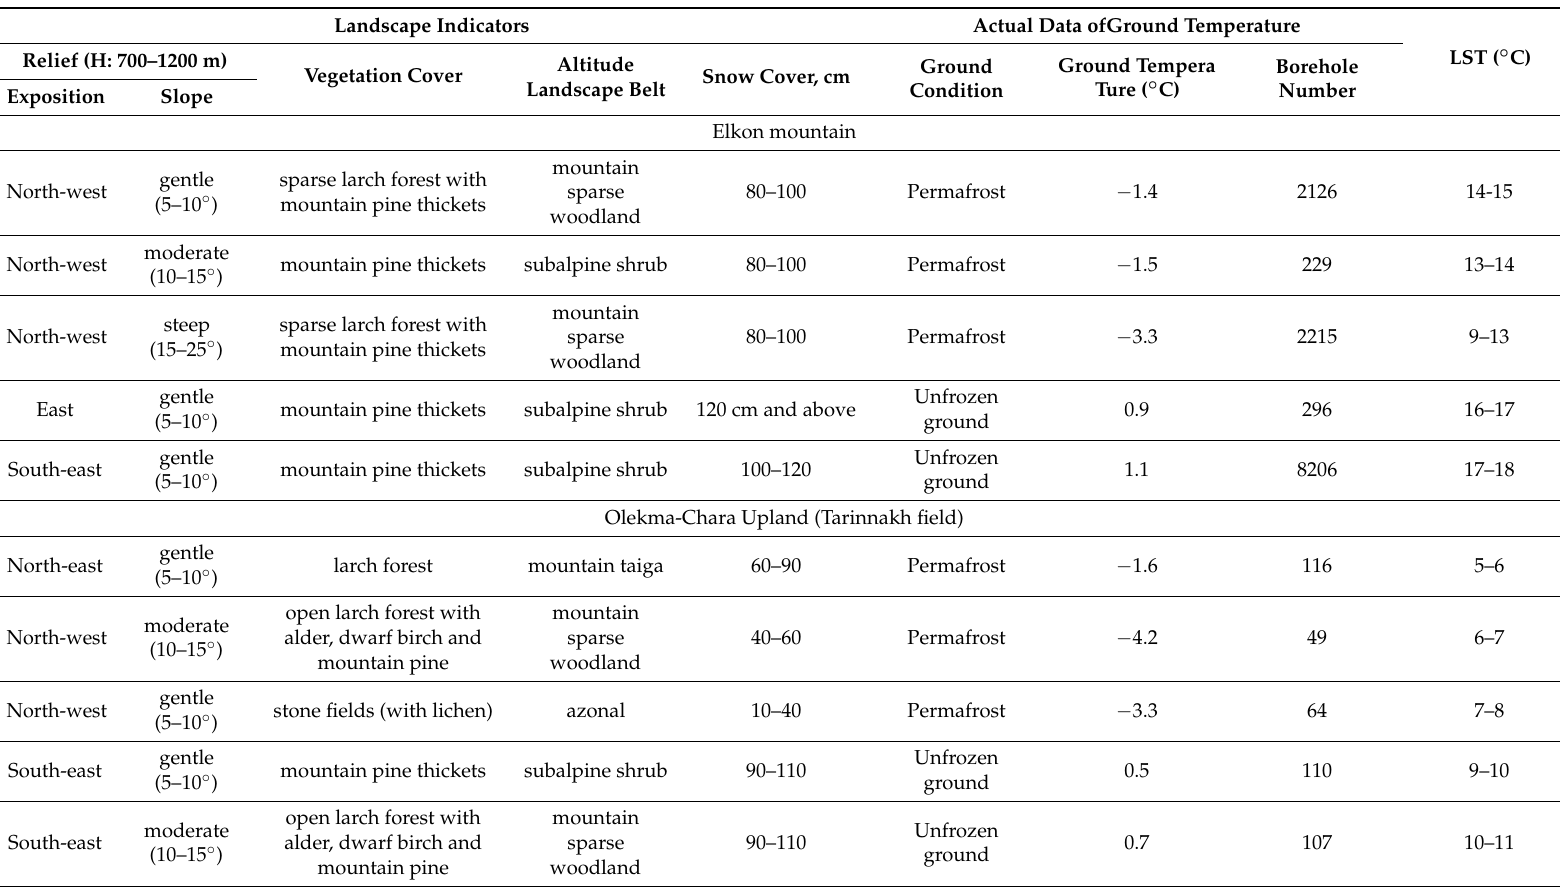
Table 2. Indicators for permafrost and unfrozen ground, Elkon Massif, Olekma-Chara Upland (Tarinnakh field), (segment). Landscape